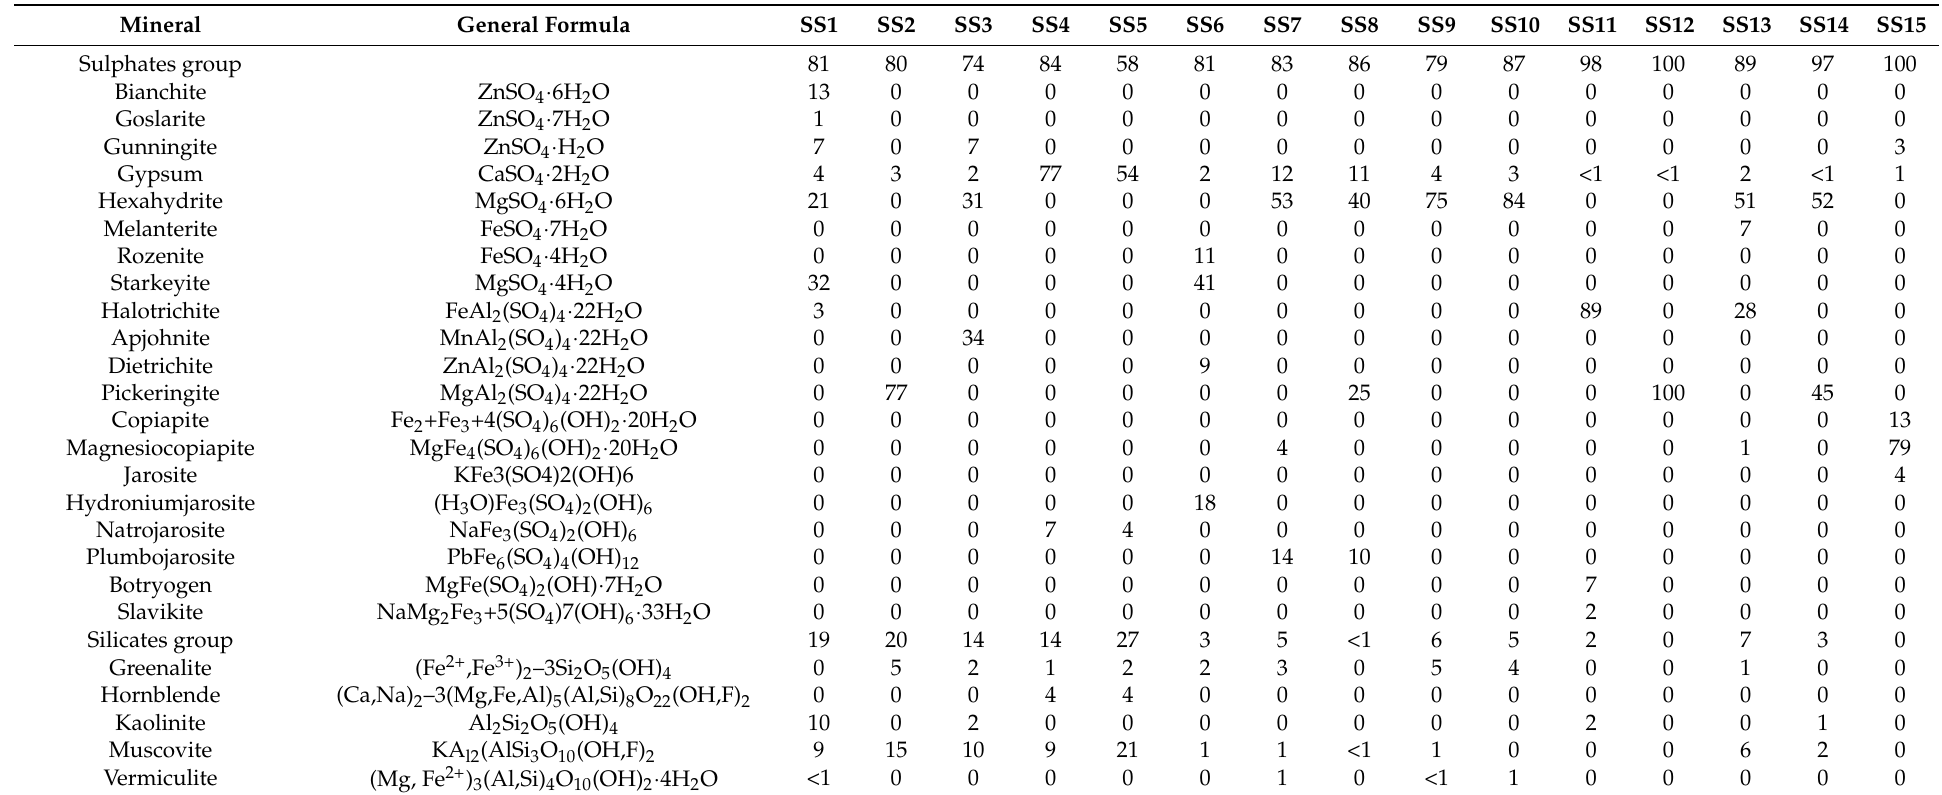
Table 1. Mineral compounds identified by XRD in the salt efflorescences analysed. Semi-quantitative analysis (wt.%). H 2 O, O.M., SO 3 and residue content (%) by